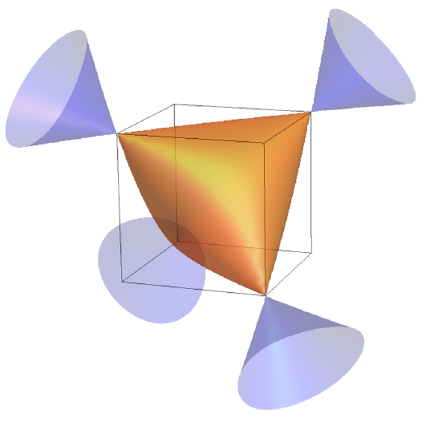
Figure 5 . The boundary between regions of di(cid:11)erent space-time signature in triangle kinematics, as dictated by the inequality (3.5). The cube separating the inner and outer shaded regions marks the boundaries G ij = (cid:6)